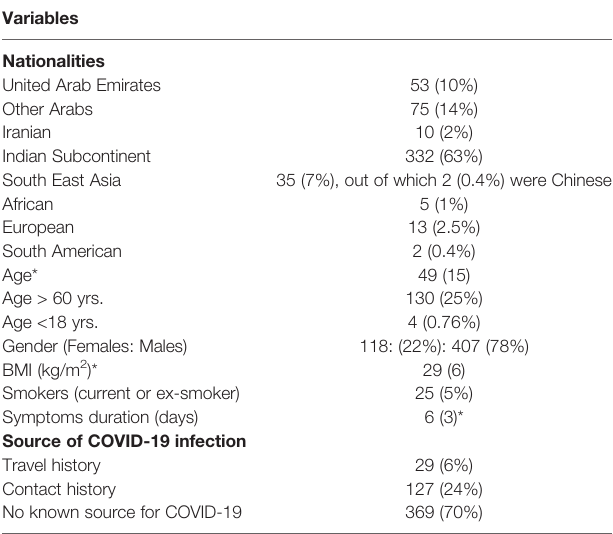
TABLE 1 | Demography of 525 symptomatic COVID-19